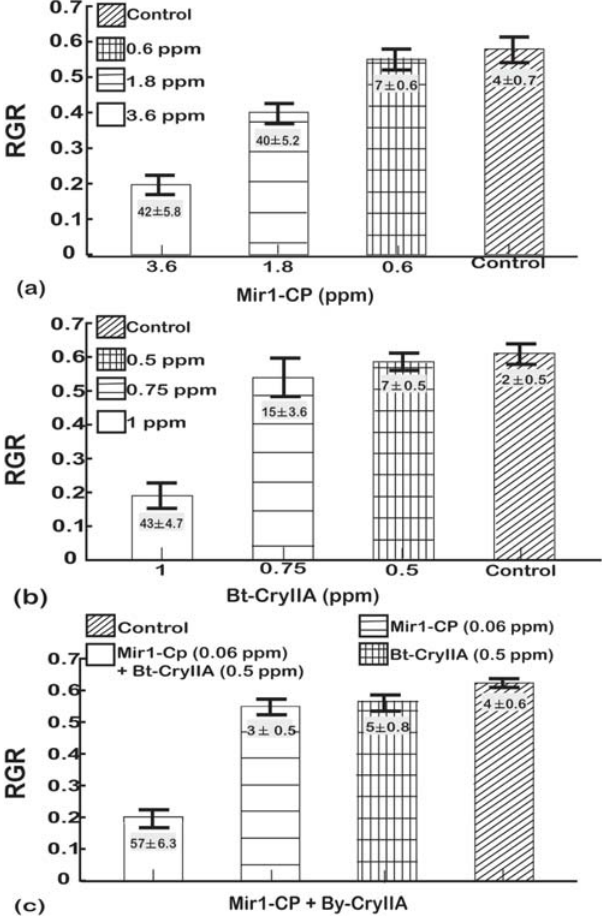
Figure 2. Dose response analysis for tobacco budworm larvae fed (a) Mir1-CP, (b) Bt-CryIIA, and (c) sub-lethal doses of Bt- CryIIA and Mir1-CP. The y-axis is the relative growth rate (RGR measured as D mg/(mg avg d) and vertical bars indicate one standard deviation. The least significant difference (LSD) at the 0.05 confidence level for the RGR values were as follows: Mir1-CP – 0.31, Bt-CryIIA – 0.44, sub-lethal doses of Bt-CryIIA and Mir1-CP combined – 0.57. Numbers (mean 6 SD) in the histogram bars are the average percentage mortality for each treatment. The least significant difference (LSD) at the 0.05 confidence level for mortality were as follows: Mir1-CP – 8.5, Bt-CryIIA – 7.4, sub-lethal doses of Bt-CryIIA and Mir1-CP combined – 15.83. Results are based on four independent bioassays. Concentrations are given as parts per million (ppm).